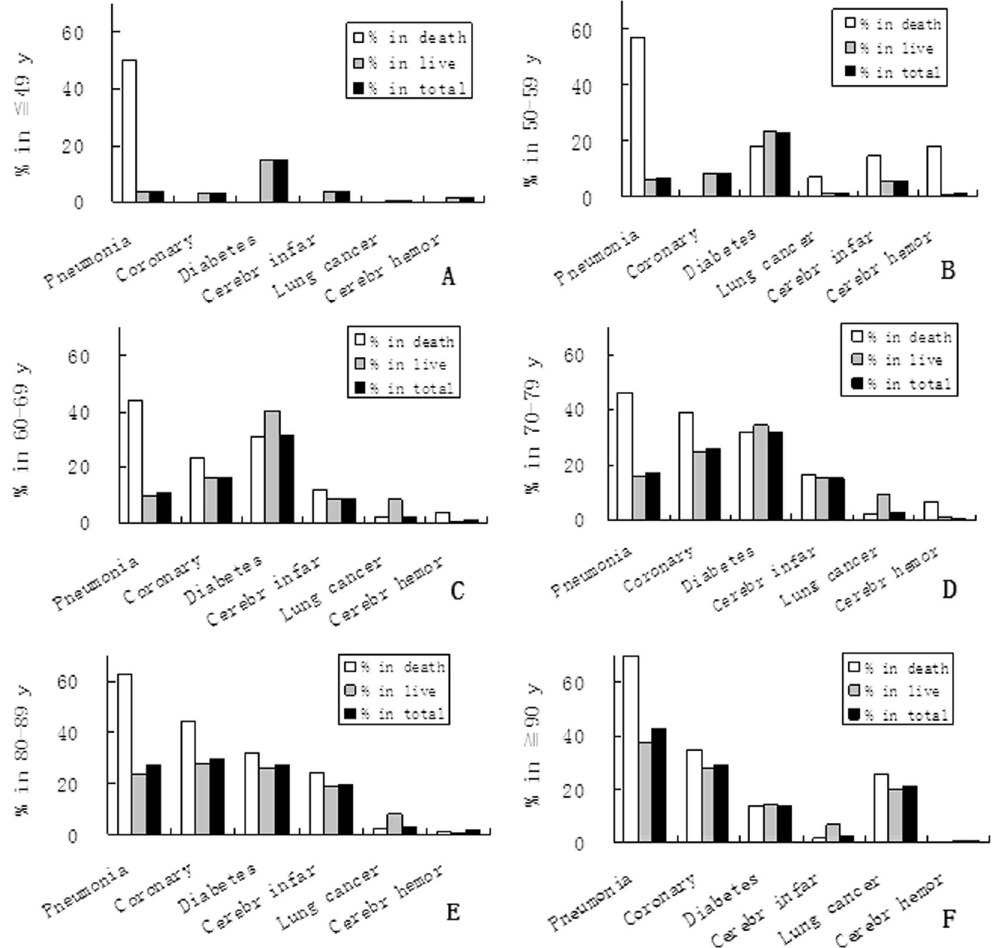
Figure 2. Death and incidence of pneumonia in hypertensive women in different age groups. The death rate of pneumonia (1st bar) is the highest compared with other diseases in all age groups, although arrangement positions of the incidences (2nd or 3rd bar) are